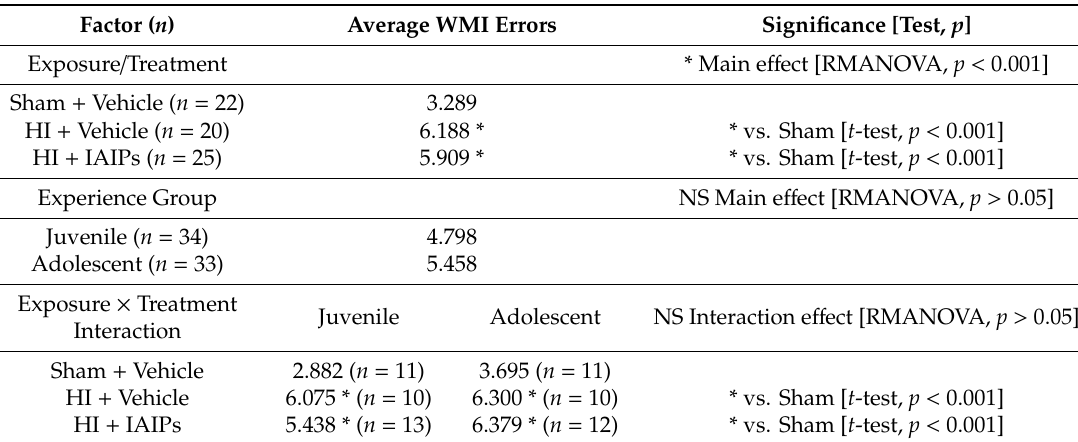
Table 1. Main and interaction e ff ect (repeated measures ANOVA) and simple means comparisons ( t -tests) of RWM errors between group factors. Sidak corrections used for t -tests with multiple comparisons. (* for a value indicates a significant paired di ff erence, see significance column, * in a column title indicates a significant overall or interaction e ff ect, as per RMANOVA.).